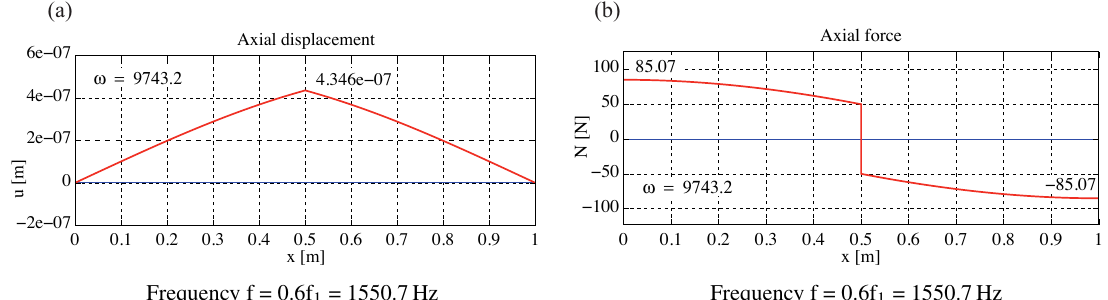
Fig. 10. Amplitudes of axial displacements and forces at 60% of first frequency.